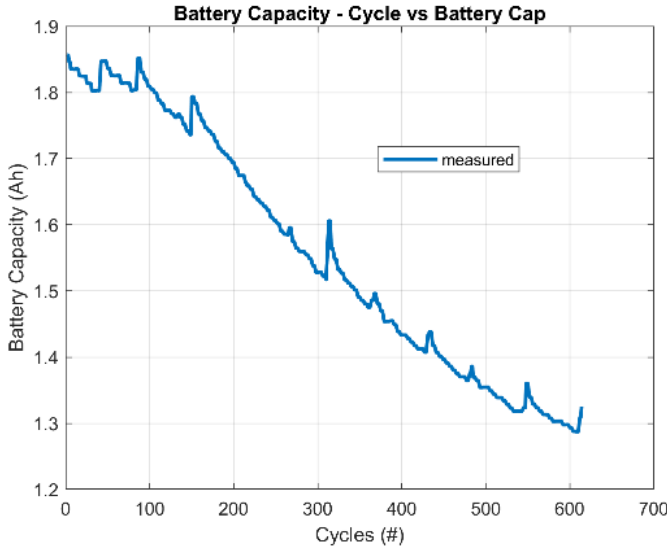
Figure 2. Measured Battery Capacity at the end of each discharge cycle [29].